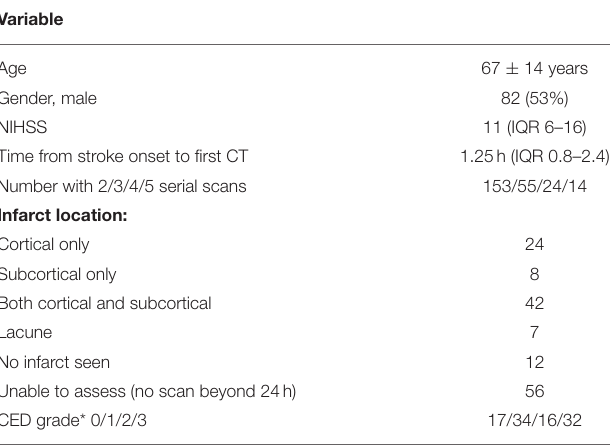
TABLE 1 | Cohort of 155 stroke subjects with baseline and follow-up CT scans.